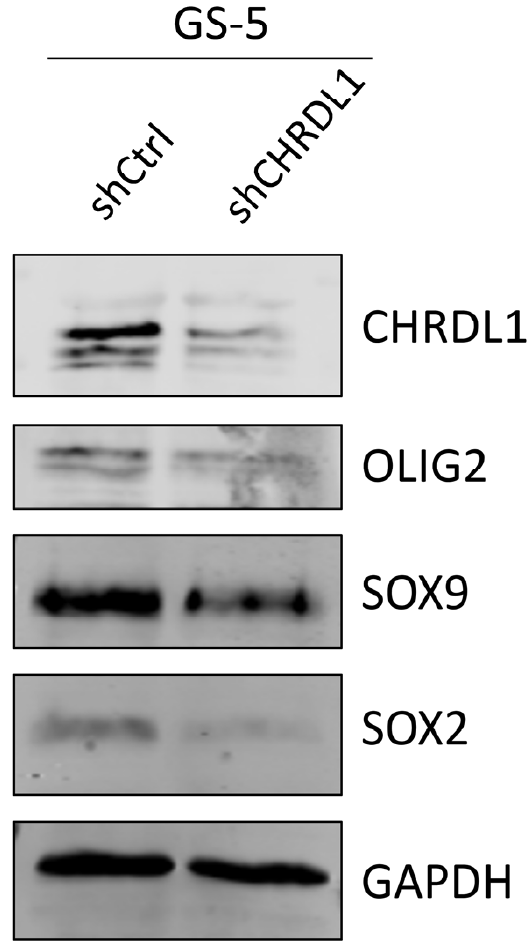
Figure 5. CHRDL1-depletion reduces stemness-associated marker protein expression. Western Blots of GS-5 GSCs after stable transduction with a non-targeting shRNA (shCtrl) or specific shRNA targeting CHRDL1 (shCHRDL1) and measurement of the protein expression of OLIG2, SOX9, and SOX2. CHRDL1 was detected to validate efficient depletion and GAPDH served as a housekeeping protein.